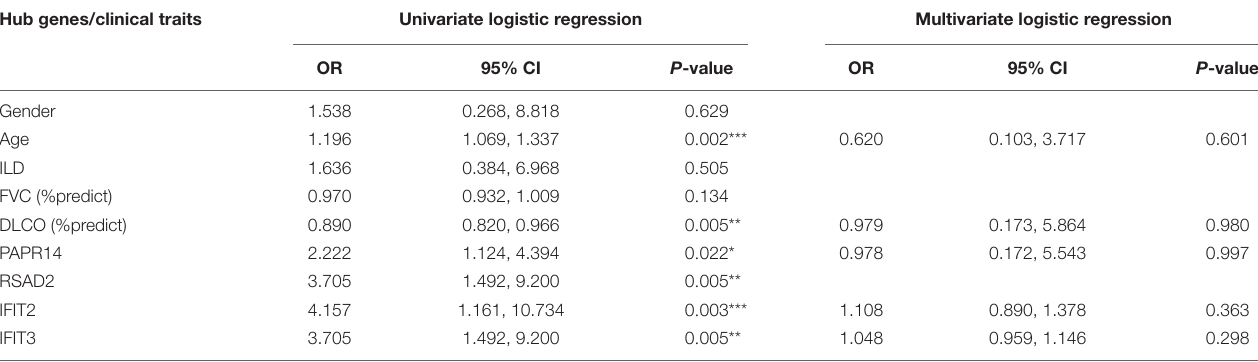
FIGURE 7 | Validation of hub genes in duplication cohort and validation cohort. (A) Relative expression of IFIT2, IFIT3, RSAD2, and PARP14 in 25 SSc and 17 SSc-PAH patients for the datasets of GSE1961. Boxplots indicating the median, log 2 (gene expression value) and 25–75% percentiles. (B) Validation of IFIT2, IFIT3, RSAD2, and PARP14 in the validation cohort (20 healthy controls, 10 SSc patients and 10 SSc-PAH patients). The results were similar to the above. *** P < 0.001, ** P < 0.01, * P < 0.05. (Student t -test). SSc, systemic sclerosis; PAH, pulmonary arterial hypertension; HCs, healthy controls; mRNA, messenger RNA; WGCNA, weighted gene co-expression network analysis. TABLE 4 | Univariate and multivariate logistic regression of hub genes and clinical traits. Hub genes/clinical